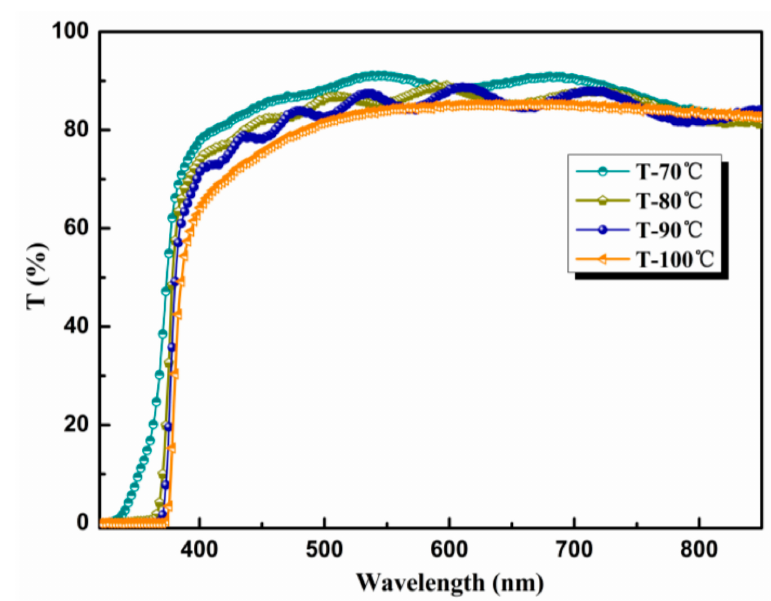
Figure 3. Total transmittance spectra of all the AZO